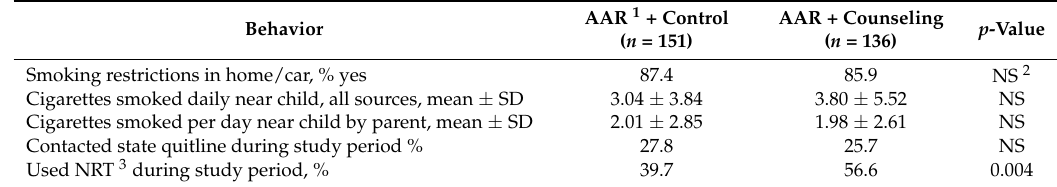
Table 2. Parent adoption of smoking cessation and protective behaviors at 12-month follow-up by condition ( n =